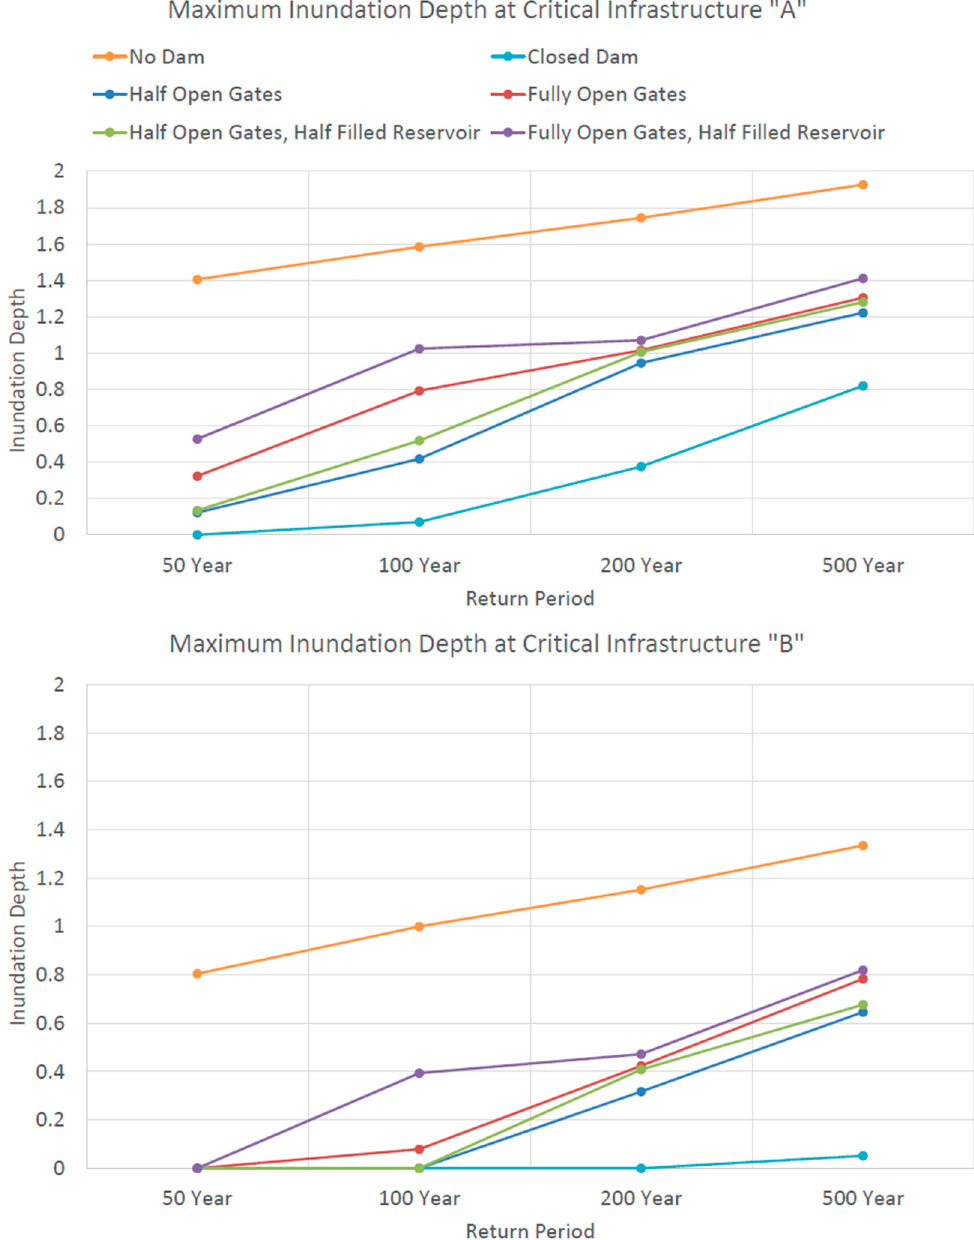
Figure 12. Simulated maximum water depth (meter) at critical infrastructure “A” and “B” for the various flooding and dam operation scenarios examined.